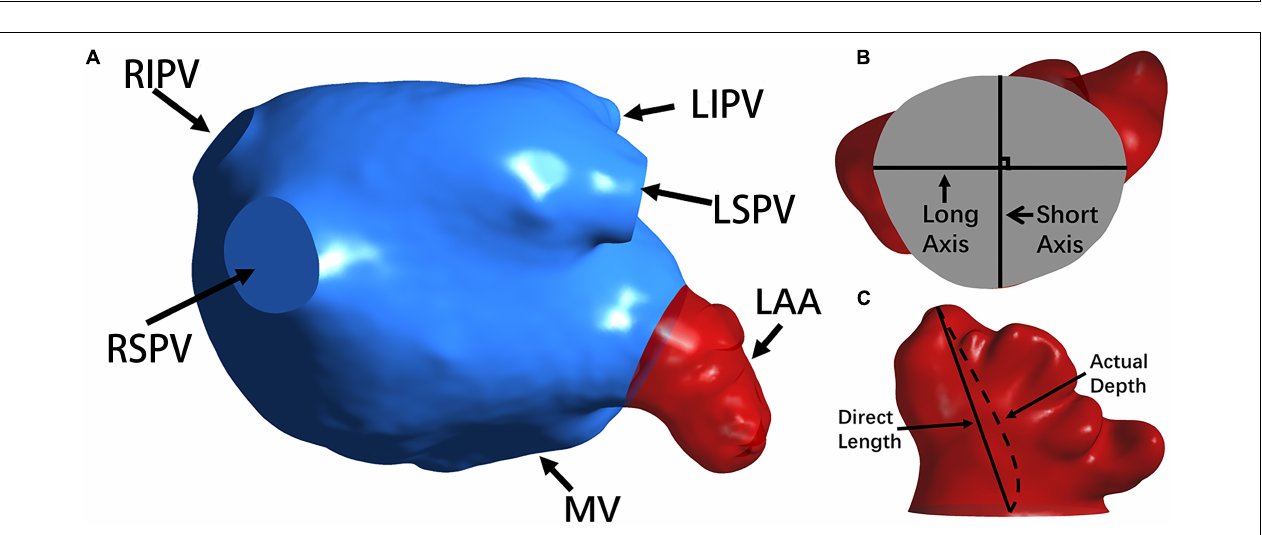
FIGURE 1 | The modeling of LA and LAA. The red arrows point to PVs, and the yellow arrows point to the MV, which is cut manually. The purple area is the LA segmented using the region growing method. (A) The coronal image of cardiac CT. (B) The axial image of cardiac CT. (C) The sagittal image of cardiac CT. (D) The 3D model of LA and LV reconstructed from the cardiac CT.